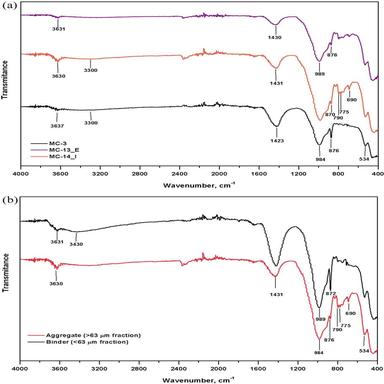
FTIR spectra of the aggregates (retaining fraction) obtained by sieving at 63 mm from samples MC-3, MC-13_E and MC-14_I (a) and FTIR spectra comparison of binder and aggregate fractions from sample MC-14_I (b).